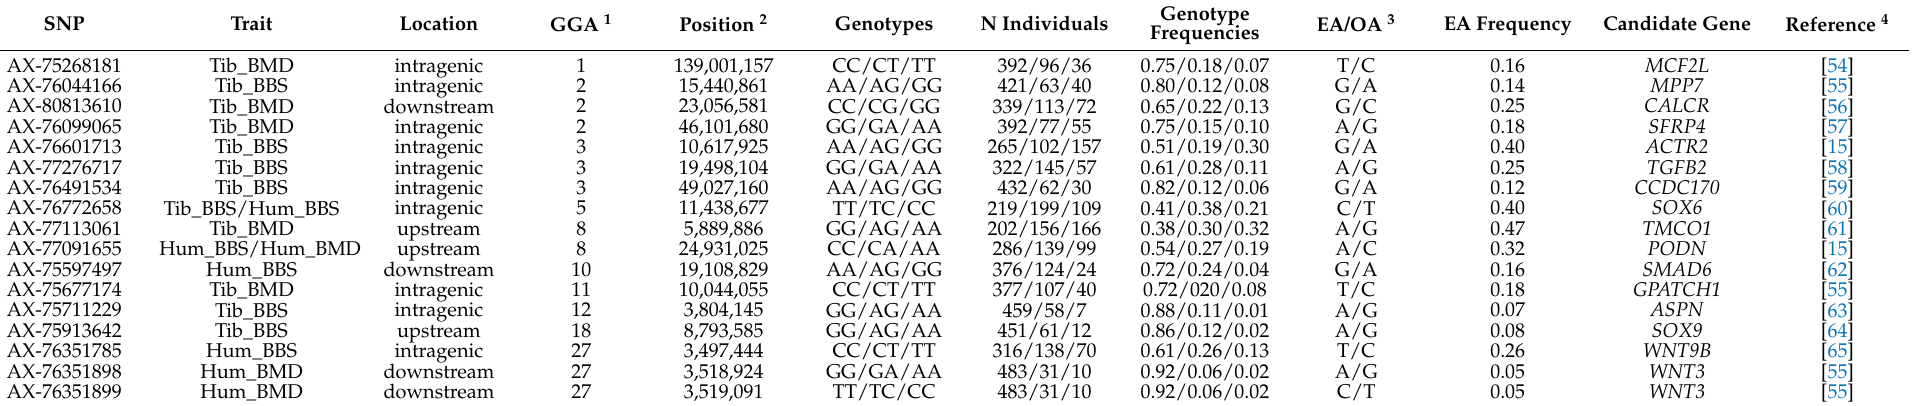
Table 1. General information for 17 loci associated with the bone breaking strengths (BBS) or bone mineral densities (BMD) of the tibiotarsus (Tib) and humerus (Hum) selected for the SNP effects